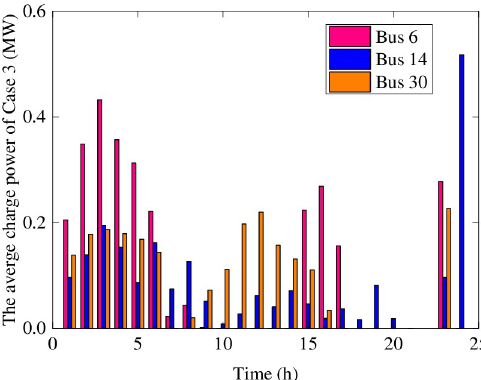
Fig 6. The average charging power of BESS in Case 4.